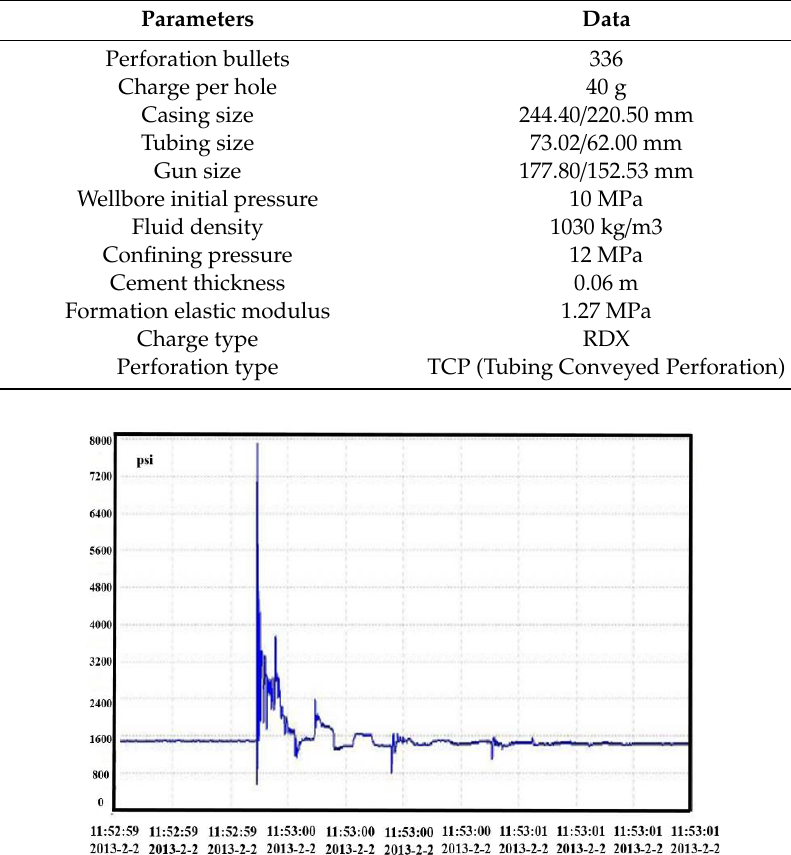
Table 8. Field case parameters.